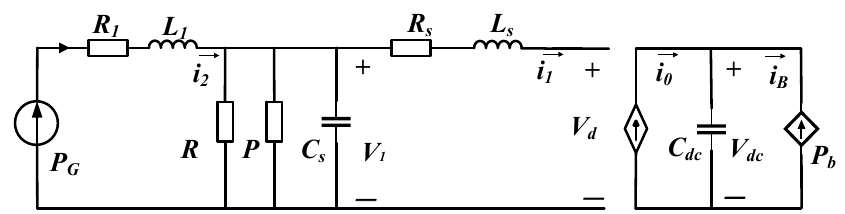
Figure 6. Nonlinear model of AC microgrid in discharge state.